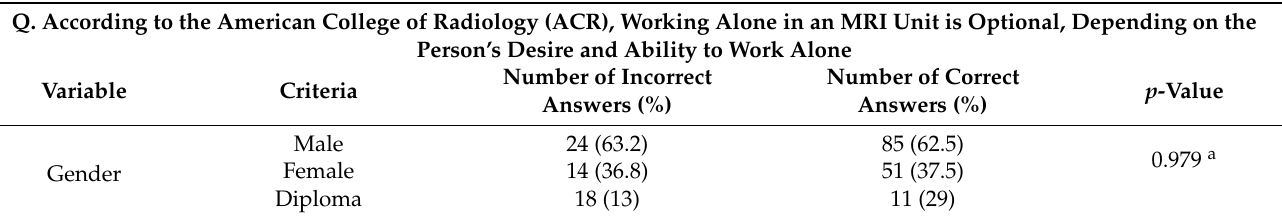
Table 3. Participants’ awareness in comparison to gender, qualifications, and